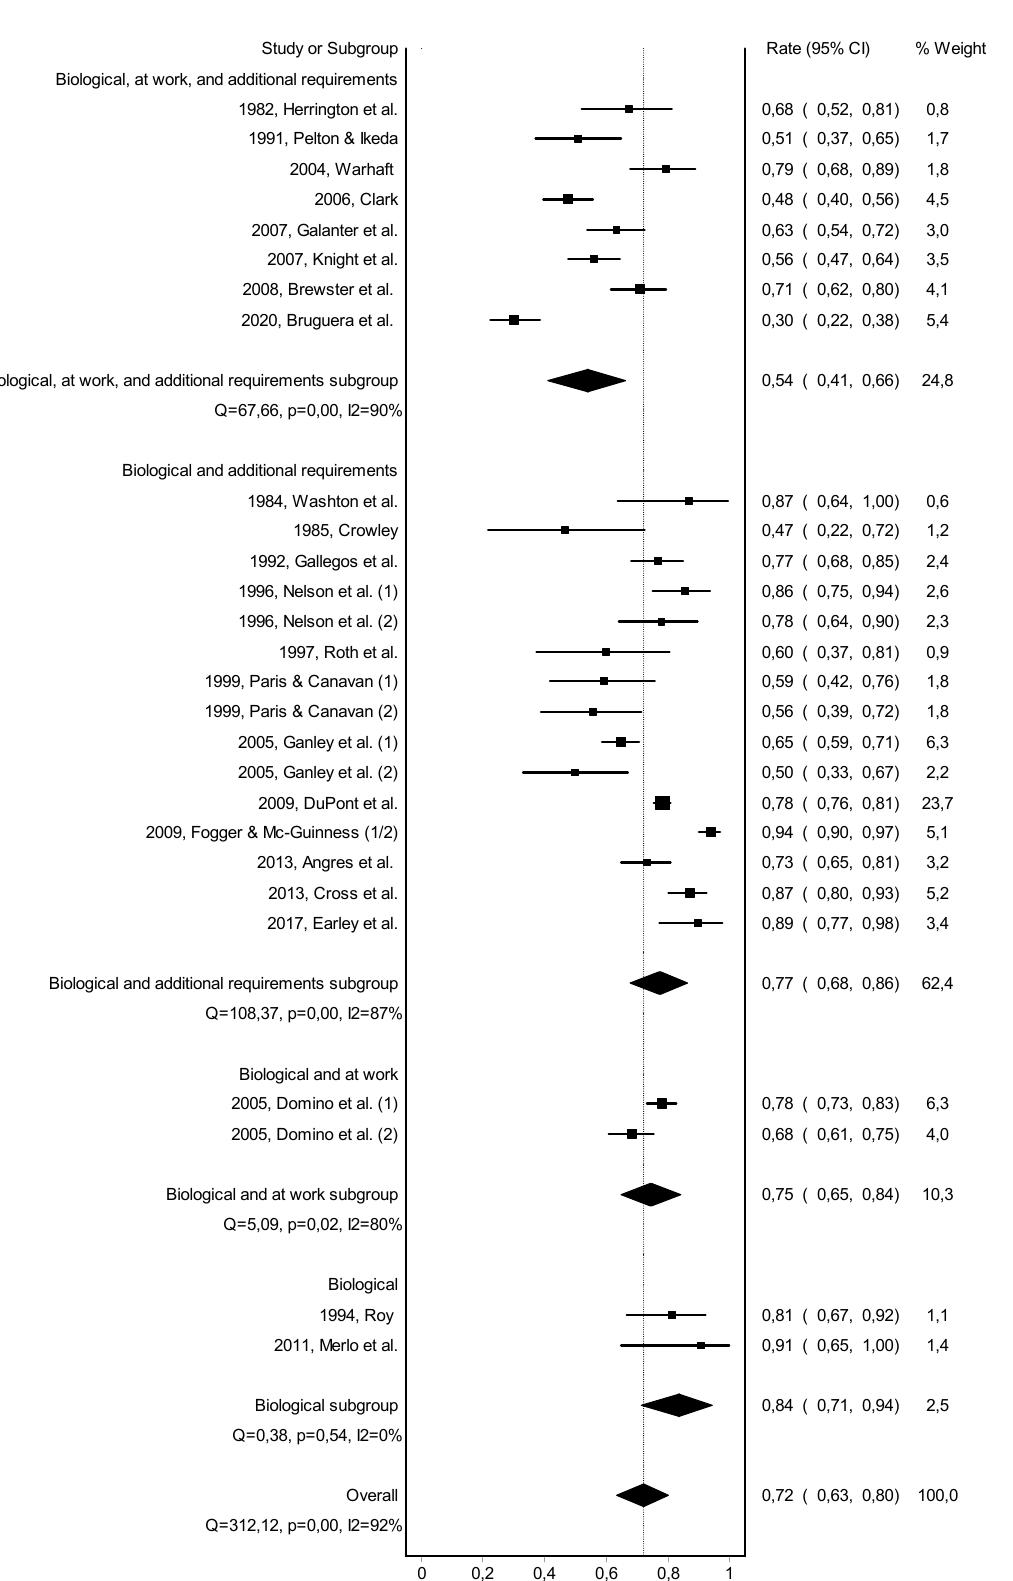
Figure A1. Forest plot of the pooled abstinence rate—subgroup analysis based on type of monitoring.